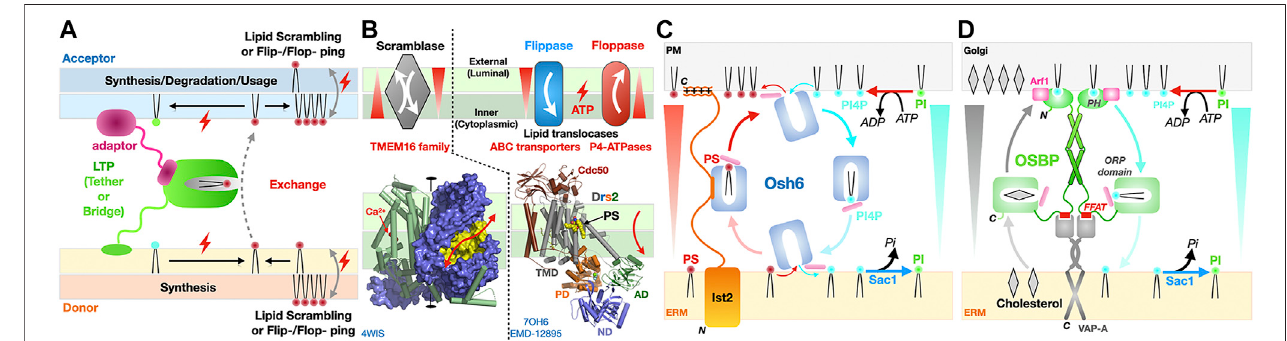
FIGURE 12 | Directionality and energetics of lipid transfer and formation of gradients and membrane asymmetry. (A) General factors determining directionality of lipidtransferatMCS.AhypotheticalLTPisdepictedhereasdirectlytetheredtothedonormembraneandattachedtotheacceptormembrane via anadaptorprotein. (B) Scramblases are bi-directional and equilibrate lipid concentrations between lea fl ets while fl ippases/ fl oppases require ATP hydrolysis to transport lipids unidirectionally against the gradient to generate membrane asymmetry. Symmetric dimer of the fungal Ca 2+ activated-TMEM16 lipid scramblase from Nectria haematococca shown as a solvent accessible surface (blue) to emphasize the presence of a hydrophilic cleft (colored in yellow) running along the side of each monomer and spanning the entire width of the membrane; the other monomer is represented as green cylinders with its two calcium ions positioned the middle plane of the membrane (red spheres) that might assist neutralizing negative charges on the PL during its transfer (PDB 4WIS). Structure of yeast P4-ATPase PS fl ippase Drs2-Cdc50 chaperone complex with its transmembrane (TMD), nucleotide-binding (ND), phosphorylation (PD) and actuator (AD) domains of the fl ippase labeled. A molecule of PS bound mid- membrane along the putative translocation path is visible (PDB 7OH6 EMD-12895). (C, D) Lipid counter fl ow transport by tethered LTPs; (C) PS/PI4P counter fl ow by Osh6atER-to-PMcontactsiteswhereIst2[onlyrepresentedonthelefthalfofpanel (C) ]istheER-to-PMtetherthatinteractswiththesolubleLTPOsh6tolocalizeitslipid transfer activity at this MCS. (D) Cholesterol/PI4P counter fl ow by dimers of OSBP at ER-to-Golgi contact sites. PI, phosphatidylinositol; PI4P, phosphatidylinositol 4- monophosphate. Directionality of lipid transfer is indicated by the cyclic colored arrows while gradients of PS, PI4P and cholesterol are indicated by shaded triangles. ATP-consuming biosynthesis provides PI4P while its irreversible hydrolysis into PI by the ER-associated phosphatase Sac1 sets the directionality of these two cycles.